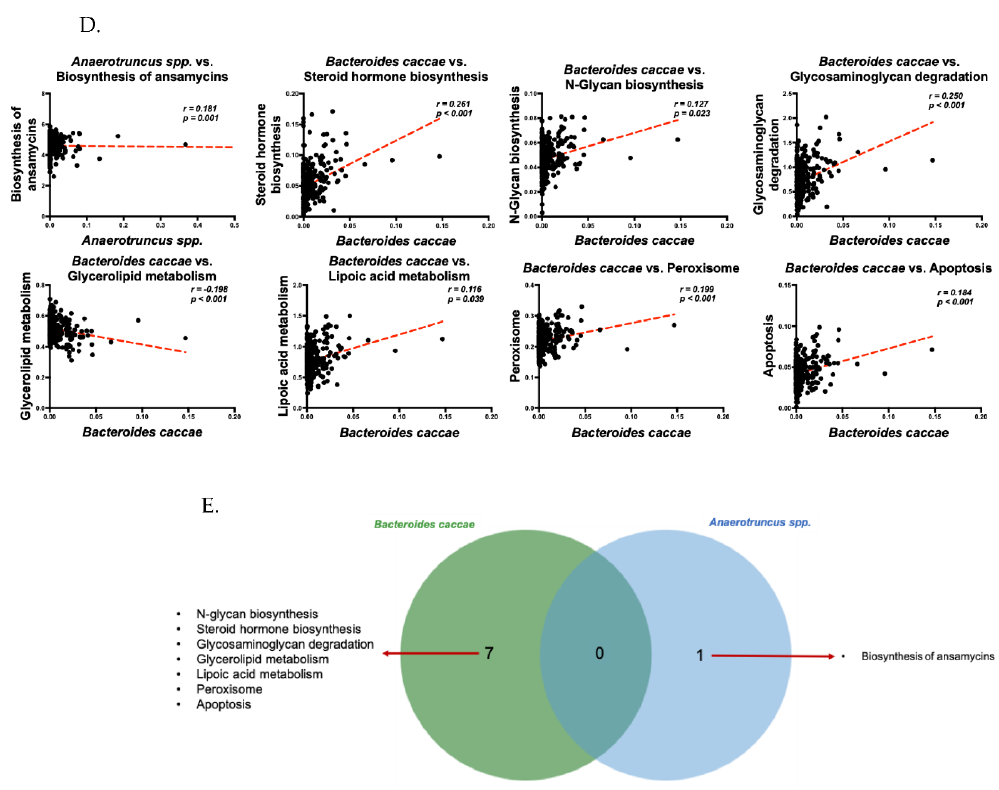
Figure 6. The correlation of Bacteroides caccae and Anaerotruncus spp. with specific functional pathways may contribute to the risk of NSCLC. Functional pathways were analyzed using PICRUSt 2 analysis and plotted using STAMP (v2.1.3) ( A ). Spearman’s correlation analysis ( B ) showed that 8 signaling pathways were significantly associated with Bacteroides caccae and Anaerotruncus spp. in the patients with NSCLC ( C ). Associated dot plot of the abundances of Anaerotruncus spp. and Bacteroides caccae with functional pathways in the NSCLC patients ( D ). Venn plot of Anaerotruncus spp.- and Bacteroides caccae -associated pathways showed no overlapping ( E